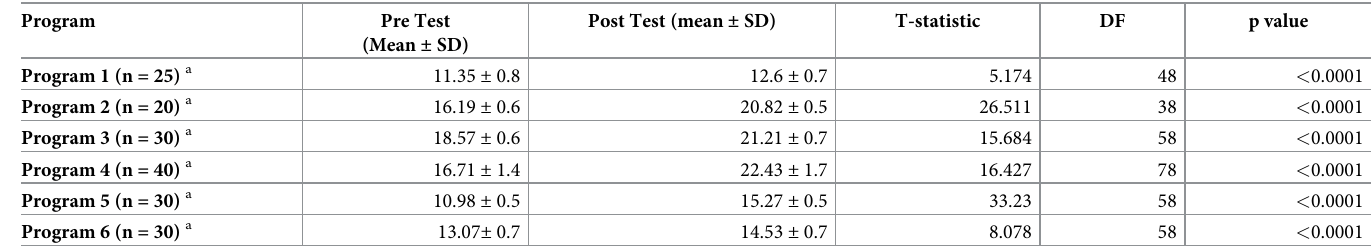
Table 5. Impact of public health management program on participant’s knowledge score.